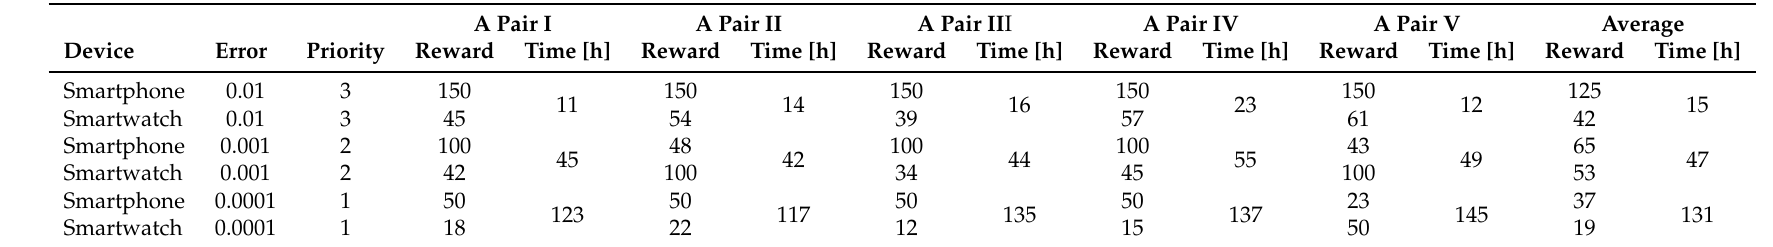
Table 3. Obtained results for a network composed of 4 hidden